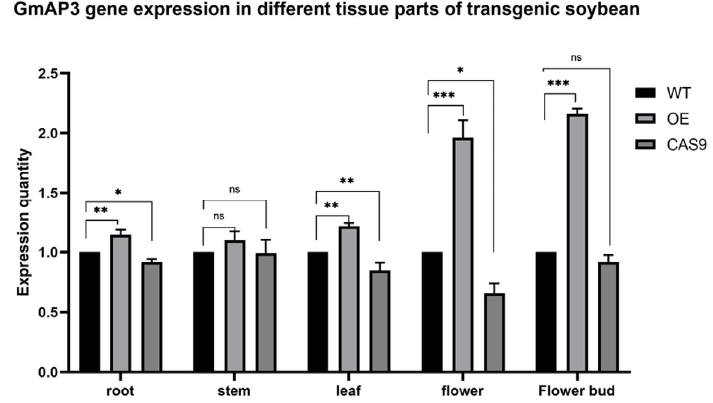
Figure 4. Expression pattern of GmAP3 in different tissues or organs of transgenic soybean. Error bars represent the standard deviation. Significant differences according to Student’s t -test are indi- cated. *, **, and *** indicate significant differences at p < 0.05, p < 0.01, and p < 0.001 levels, respec- tively.